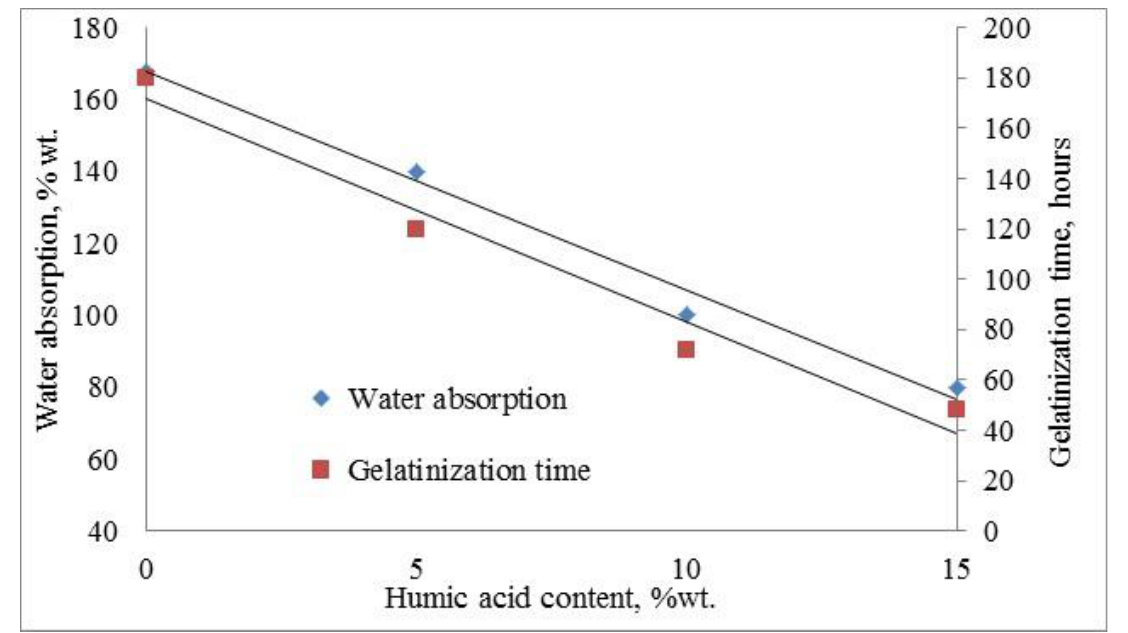
Figure 5. Graphical dependence of water absorption and gelation time of HESBHM based on hydroxypropyl methylcellulose and the humic acid